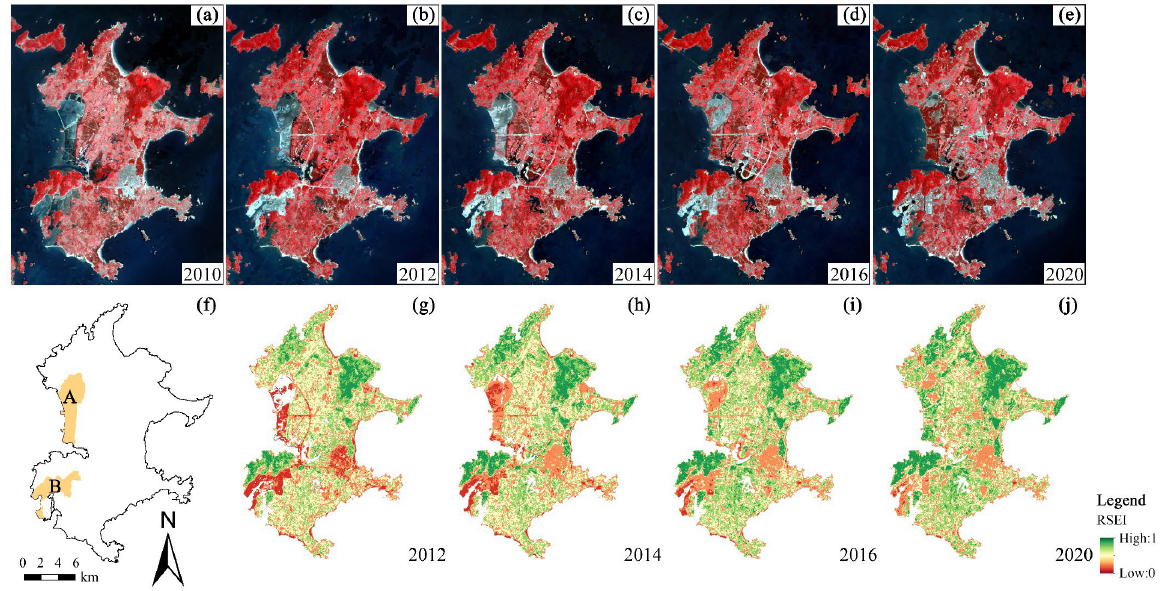
Figure 10. Analysis of remote sensing-based ecological index (RSEI) changes in reclamation. ( a – e ) Landsat images, shown in near-infrared, red, and green; ( f ) locations of A and B reclamation areas; ( g – j ) RSEI in 2012, 2014, 2016, and 2020, respectively.